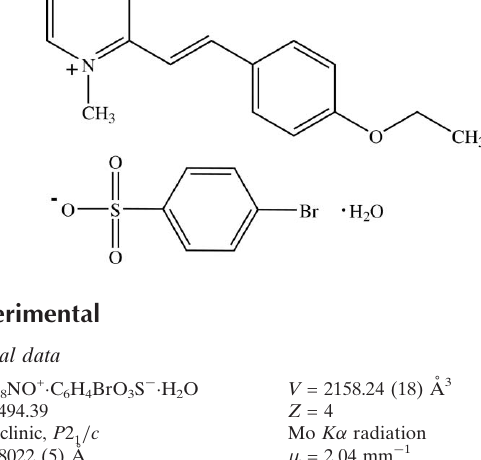
Bruker APEXII CCD area-detector diffractometer Absorption correction: multi-scan ( SADABS ; Bruker, 2005)